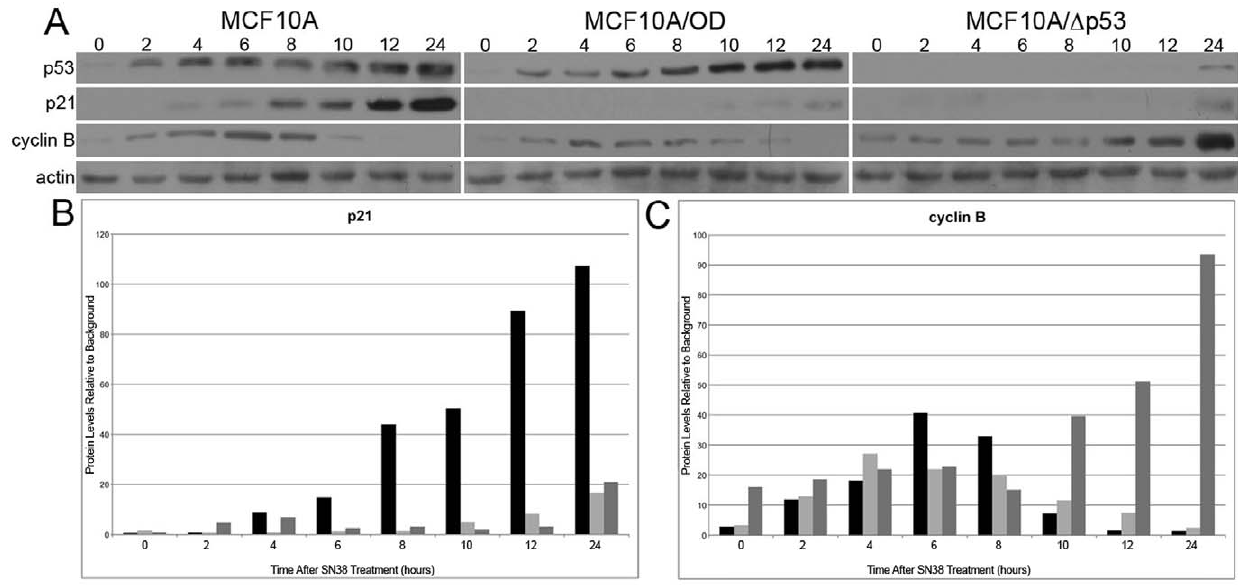
Figure 3. Timecourse of cyclin B and p21 expression following SN38 treatment. MCF10A, MCF10A/OD, and MCF10A/ D p53 cells were treated with 30 ng/ml SN38. A , Cells were harvested at the indicated time points and lysates were analyzed using SDS-PAGE followed by immunoblotting with the indicated antibodies. Band intensity of scanned immunoblots was measured using Image J software and the measurements were normalized to background. B , p21 and C , cyclin B levels were plotted for MCF10A (black bars), MCF10A/OD (light gray bars), and MCF10A/ D p53 (dark gray bars).